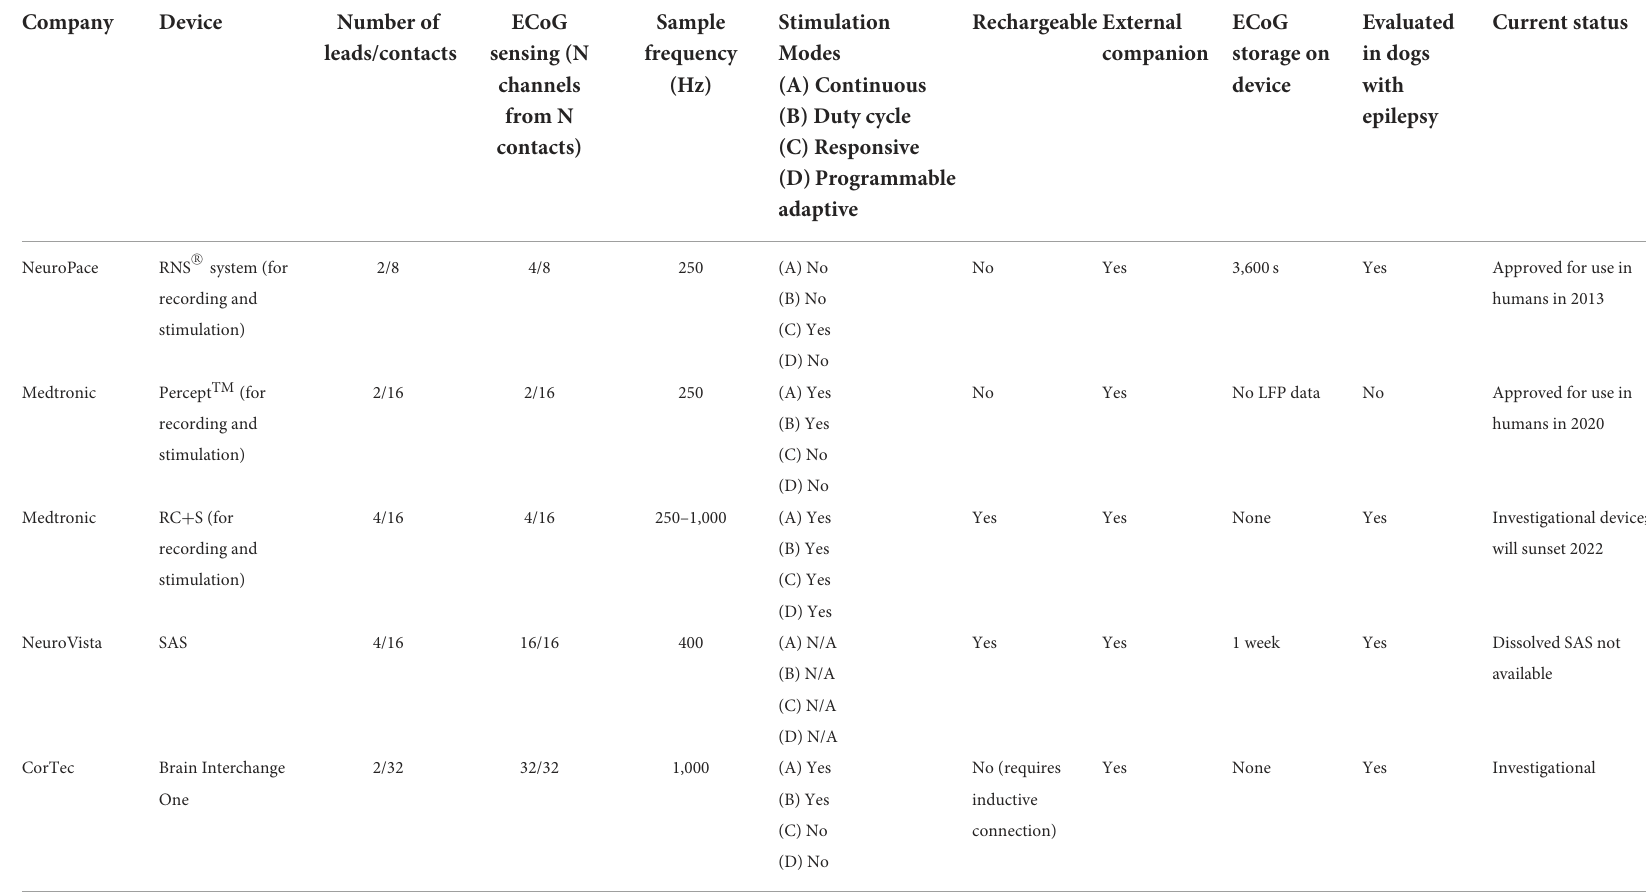
TABLE 2 Overview and characteristics of intracranial EEG (iEEG) devices certified or currently in development for humans.